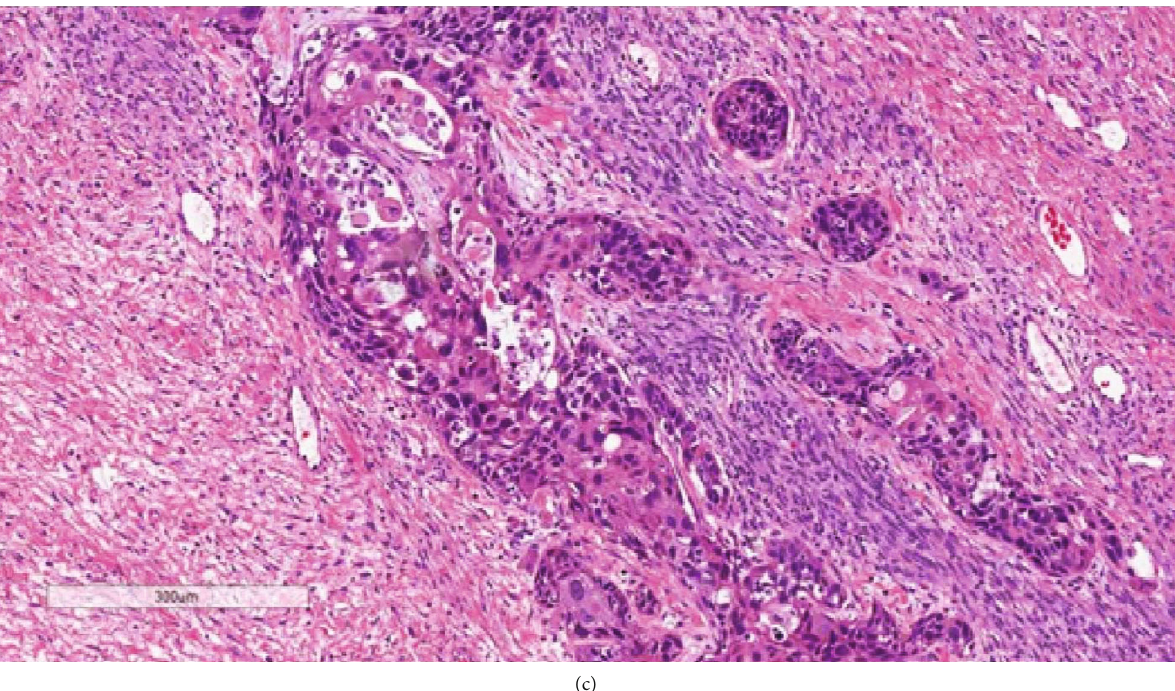
Figure 2: (a) Brenner tumor component from low power ( × 20 magni fi cation; H&E stain). (b) Benign Brenner tumor lined with transitional epithelium in a fi brous stroma ( × 200 magni fi cation; H&E stain). (c) Malignant Brenner tumor invading adjacent stroma ( × 200 magni fi cation; H&E